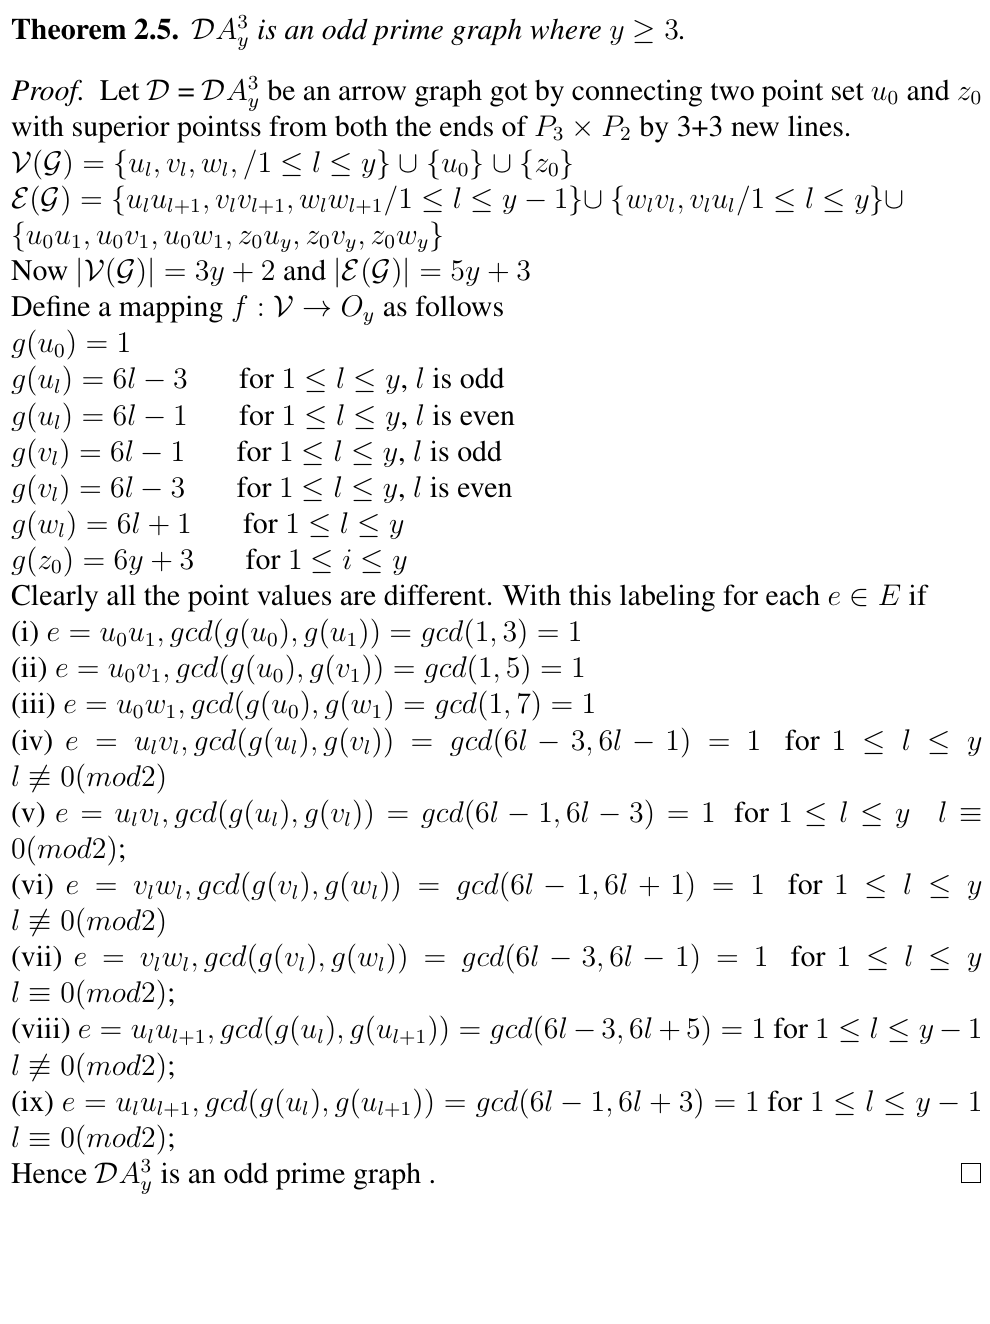
and its odd prime y